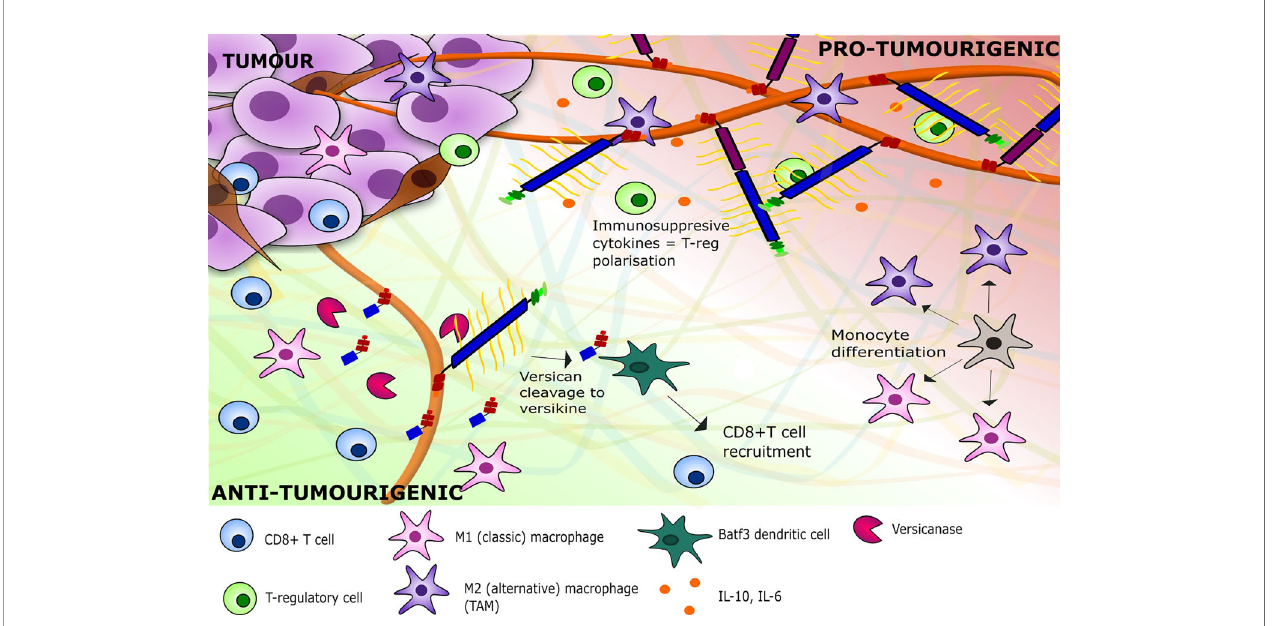
FIGURE 5 | A depiction of the in fl ammatory milieu of versican V0/V1 and versikine and their respective effects on tumour immunity. V0/V1 presence leads to the stimulation of immune-suppressive cytokines within the TME, leading to a pro-tumourigenic environment with polarisation of immune cells to TAMs and regulatory T cells. The breakdown of V1 by versicanases such as ADAMTS1 leads to an adaptive immunity against the tumour with recruitment of CD8+ T cells and polarisation of monocytes towards M1 macrophages. ADAMTS1, ADAM Metallopeptidase with Thrombospondin Type 1 Motif 1; TAM, Tumour-associated